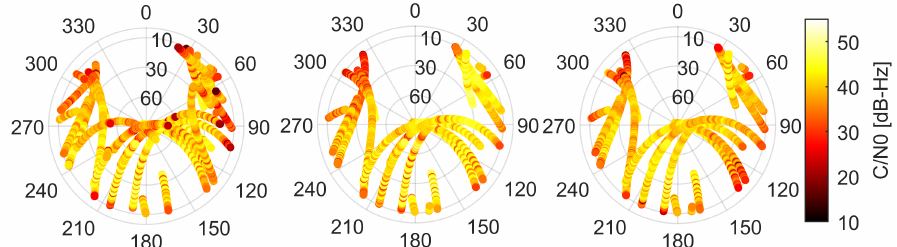
Figure 3. C / N 0 skyplots of GNSS signals collected by Xiaomi Mi 8, Xiaomi Mi 9, and Huawei P30 in left, middle, and right panels, respectively.